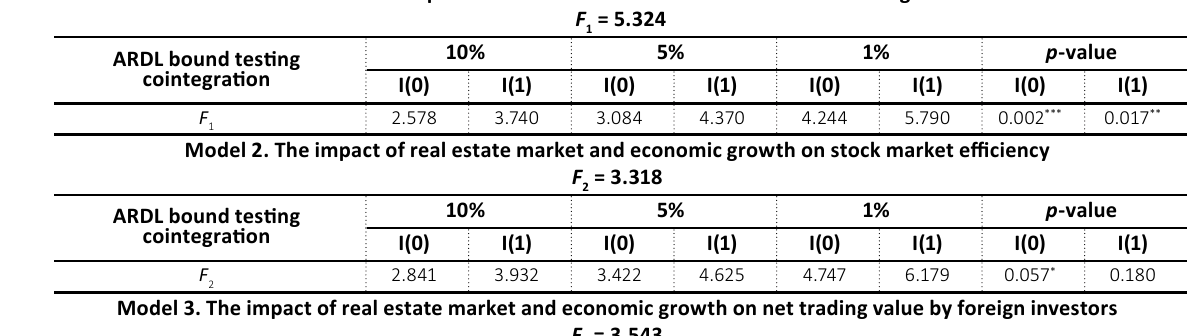
Model 1. The impact of stock and real estate market on economic